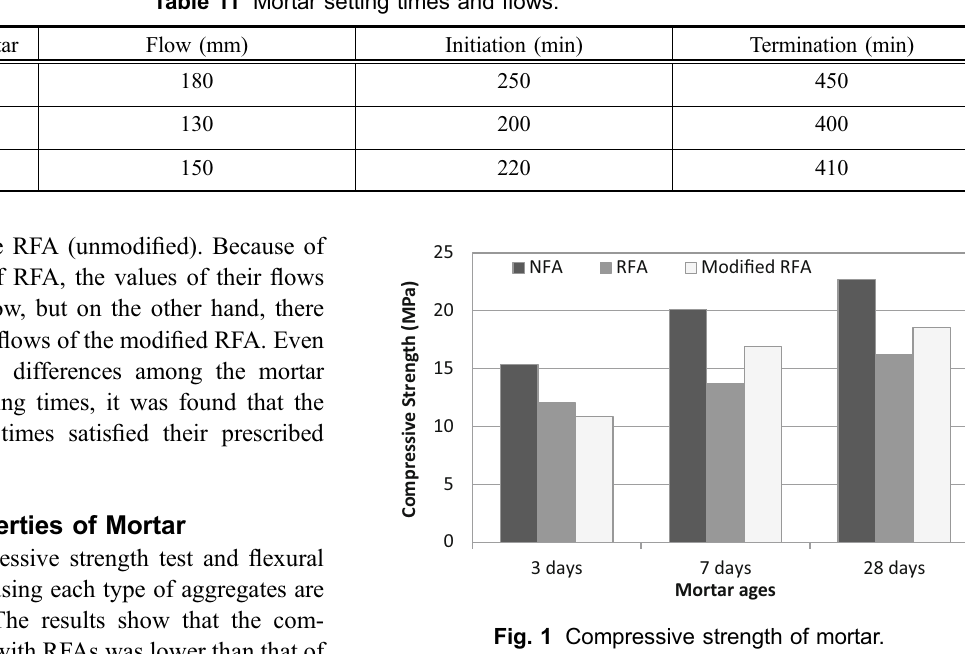
Fig. 1 Compressive strength of mortar.